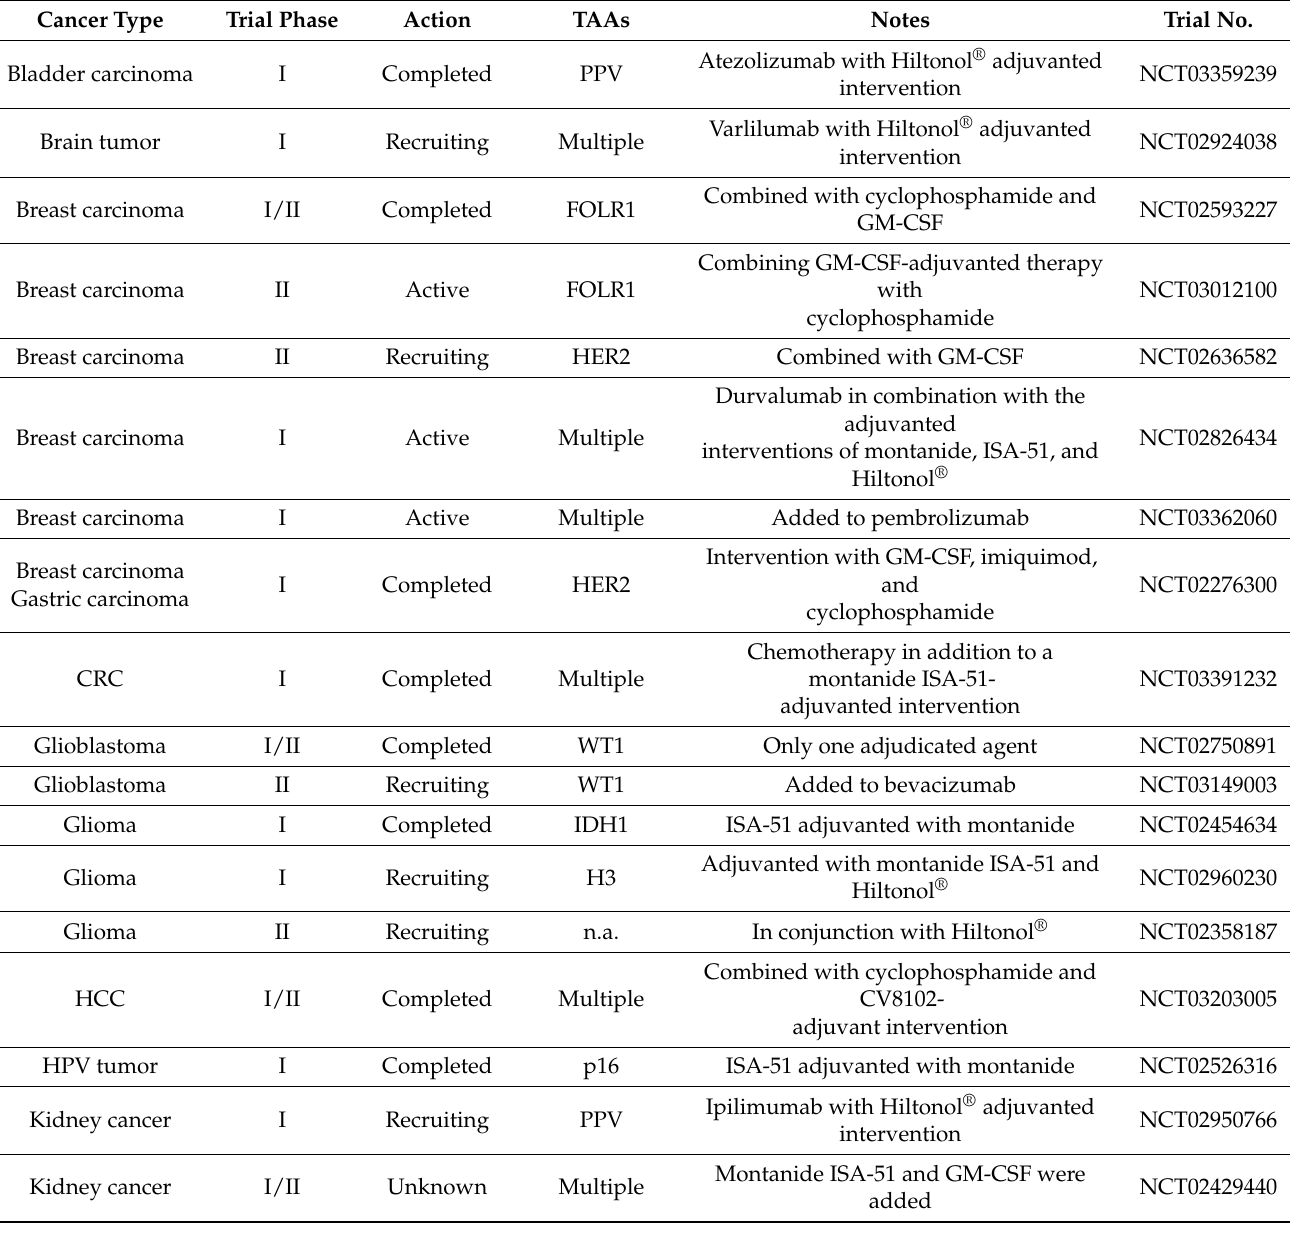
Table 4. Investigational trials examining the efficacy of TAAs or peptides in treating cancer